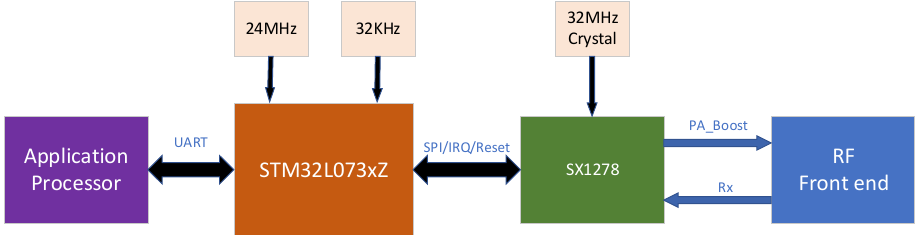
Figure 7. The design hardware structure of LoRa module. SPI = serial peripheral interface; IRQ = interrupt request; PA = power amplifier; Rx = receive; RF = radio frequency. Sensors 2018 , 18 , x FOR PEER REVIEW